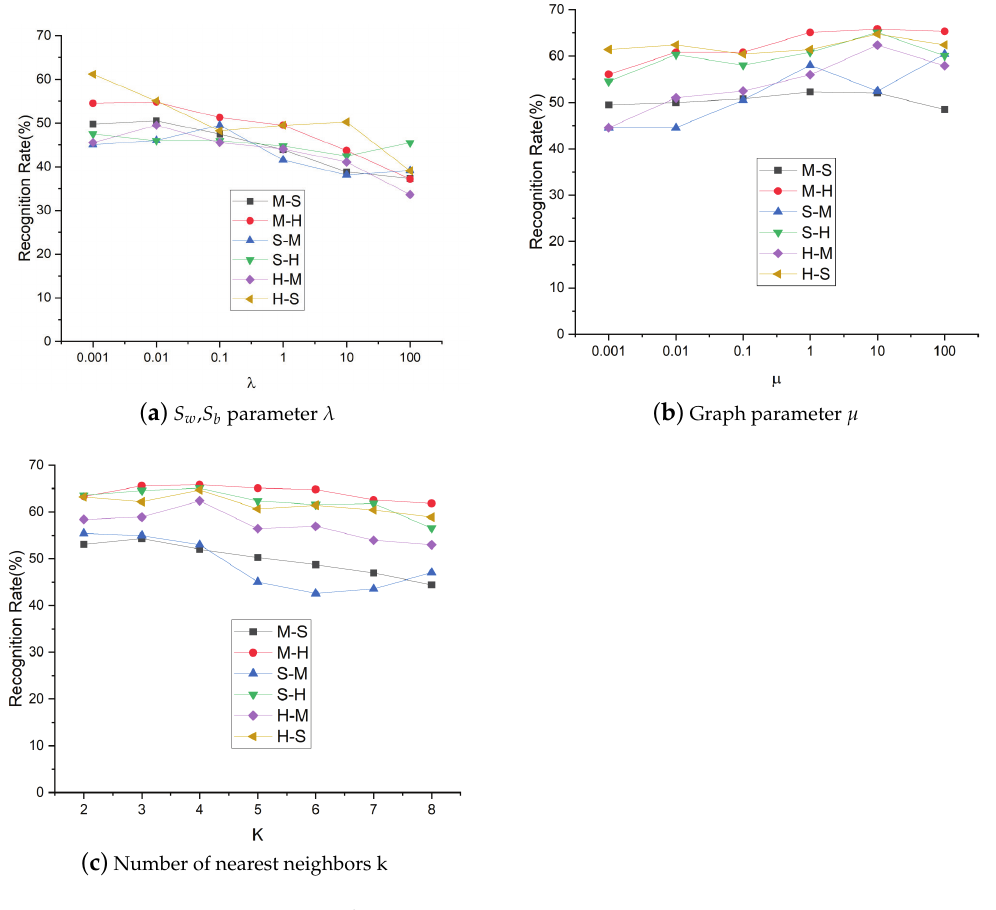
Figure 4. Parameter sensitivity